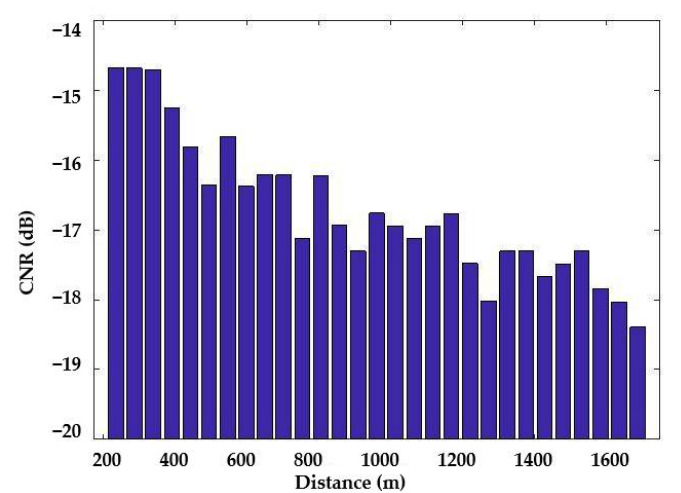
Figure 11. The relationship between the CNR and the detection range.